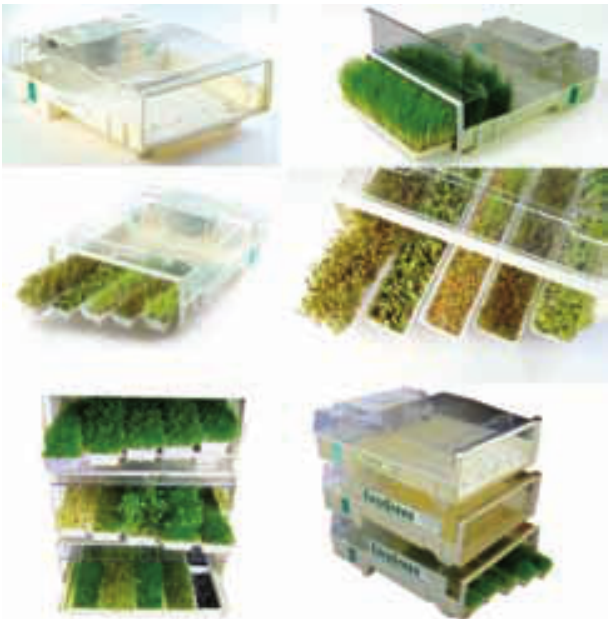
Fig. 1: Micro-farm, as a model for plant nutrition and soil fertility research. These photos represent the using of micro-farm for sprouts production as well as for different plant nutrition research. These photos with kind per- mission from Eric Viard